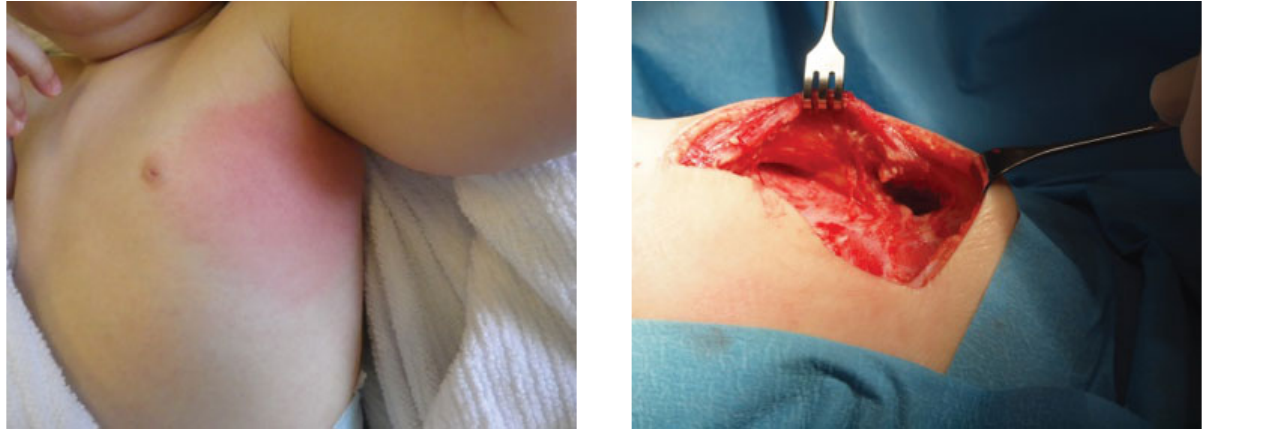
Fig. 1 Initial clinical demonstration leading to the diagnosis.